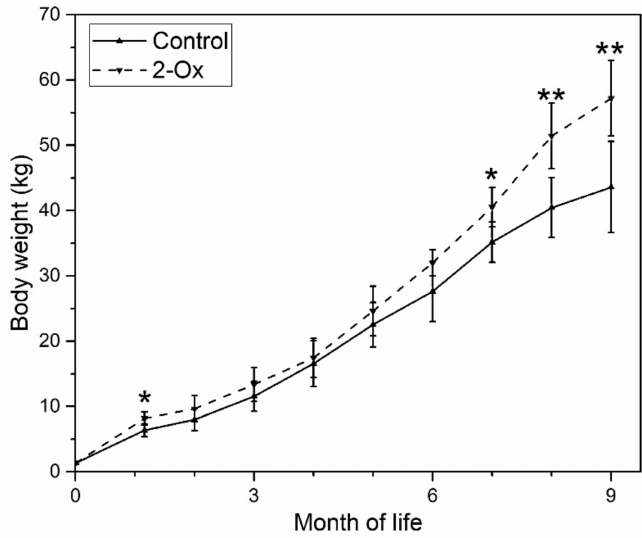
Figure 2. The e ff ect of dietary supplementation of 2-Ox on body weight in glucocorticoid (GC)-induced retarded mature gilts. Control—the control group included retarded gilts not supplemented with 2-Ox; 2-Ox—the 2-Ox group included retarded gilts supplemented with 2-Ox. Data are mean values ± SD. Statistical significance: * p < 0.05; ** p < 0.01 (two-tailed Student’s t